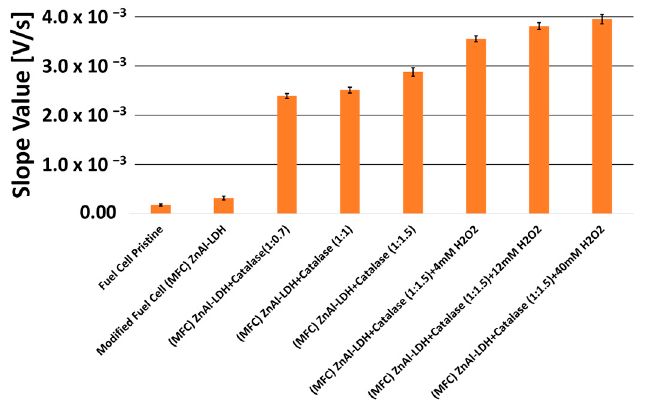
Figure 6. Comparison via bar chart diagram of the slope values of the tangent line at the point of maximum slope to the obtained voltage–charge curves, without or with LDHs, or with the addition of catalase enzyme at different weight ratio (1:0.7; 1:1; 1:1.5), or in the presence of different concentrations of hydrogen peroxide in solution, i.e., 4, 12, and 40 mmol L − 1